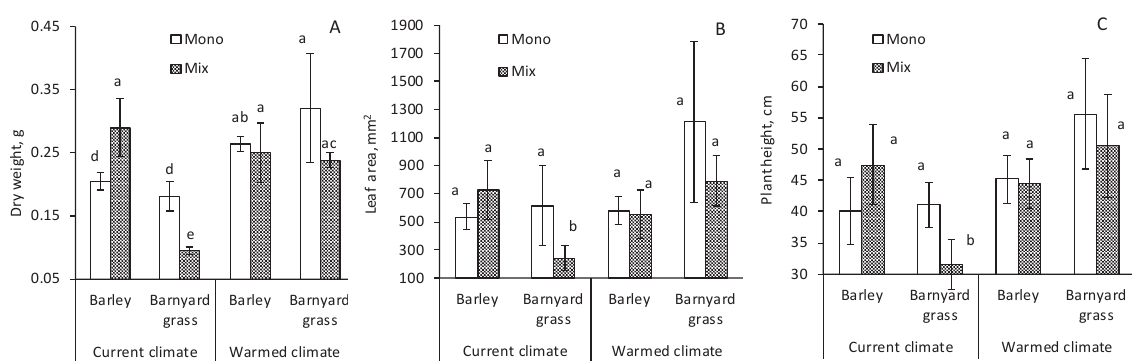
Fig. 1. The changes in dry weight (A), leave area (B) and plant height (C) of barley ( Hordeum vulgare L.) and barnyard grass ( Echinochloa crus-galli L.) plants grown in monoculture (Mono; 15 plants per pot) and mix culture (Mix; 9 crop plants and 6 weeds) under the current climate (400 µmol mol -1 CO ; day/night temperatures 21/14 °C) and the warmed climate (800 µmol mol -1 CO 2 temperatures 25/18 °C) conditions. Each value represents the mean ±CI (n=3). Different letters indicate significant differences at p <0.05 between the treatments as determined by Least Significant Differences (LSD) test.